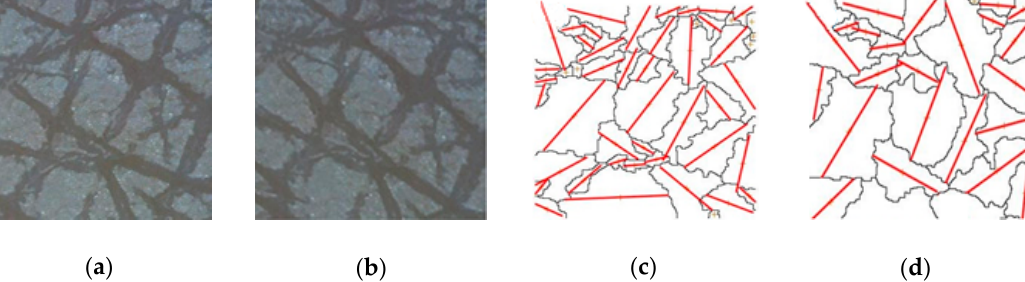
Figure 8. Cell vector expansion results—( a ) merged image; ( b ) cell vector expansion; ( c ) cell vector; ( d ) expanded cell vector. Algorithm 4. Cell vectors Algorithm 3. Wrinkle width expansion